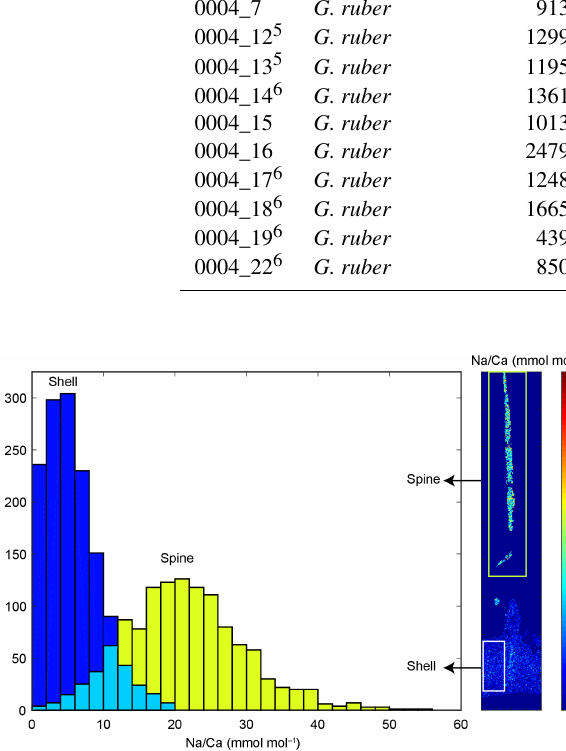
Figure 3. Comparison between spine Na / Ca values (green columns) and shell Na / Ca values (blue columns) within the same specimen (specimen 0002_13, T. sacculifer , Table 3) and EPMA- map indicating the regions represented by the histograms (white box: shell; green box: spine). The turquoise color represents the overlap region of the spine and shell histogram (not the spine base). Clearly, spine Na / Ca values are higher compared to shell Na / Ca values.